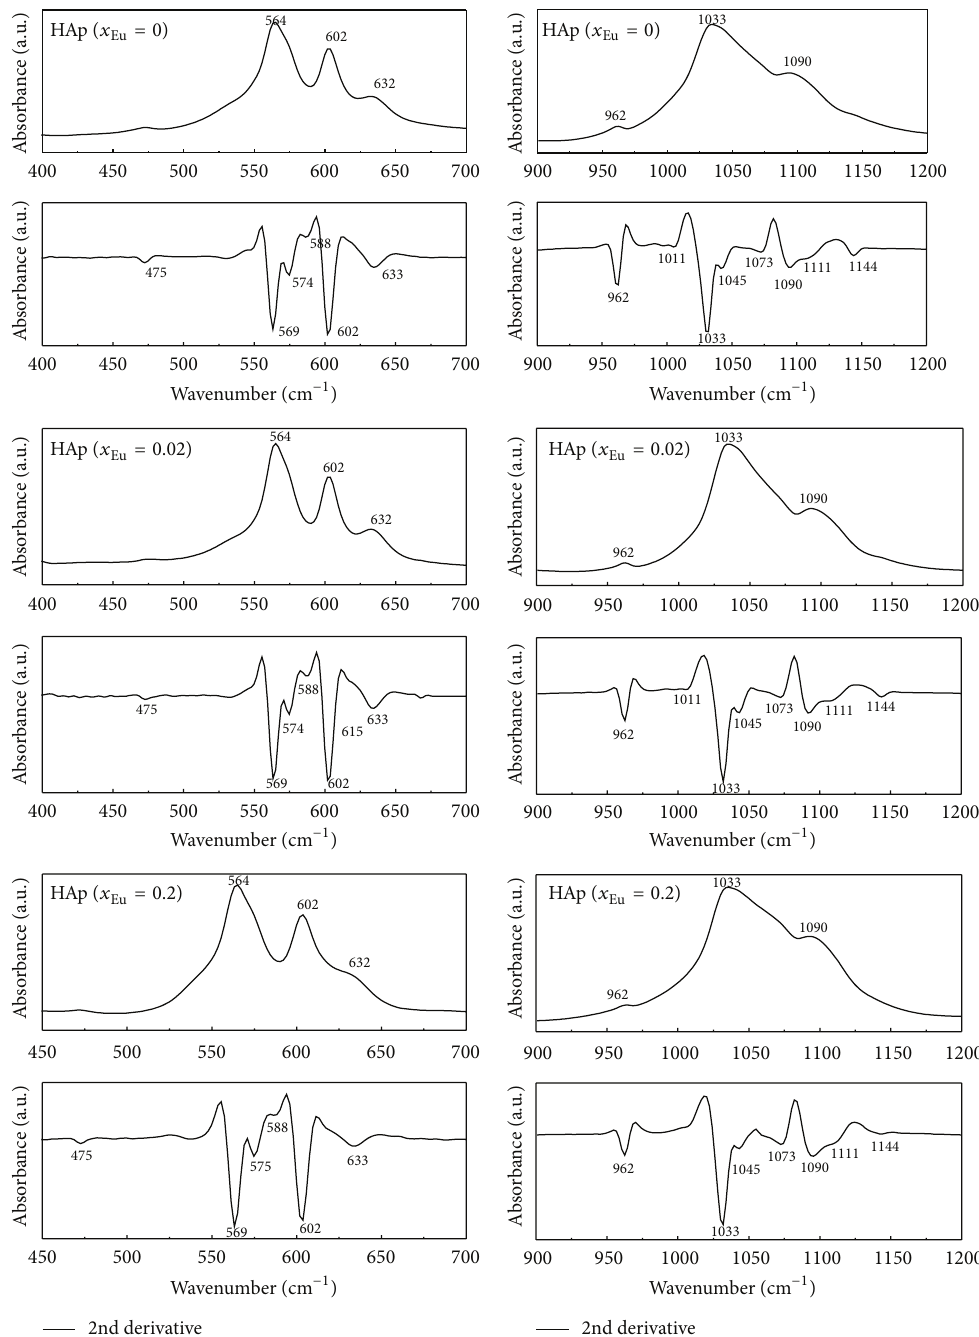
= 0 , 𝑥 = 0.02 , and 𝑥 Eu Eu